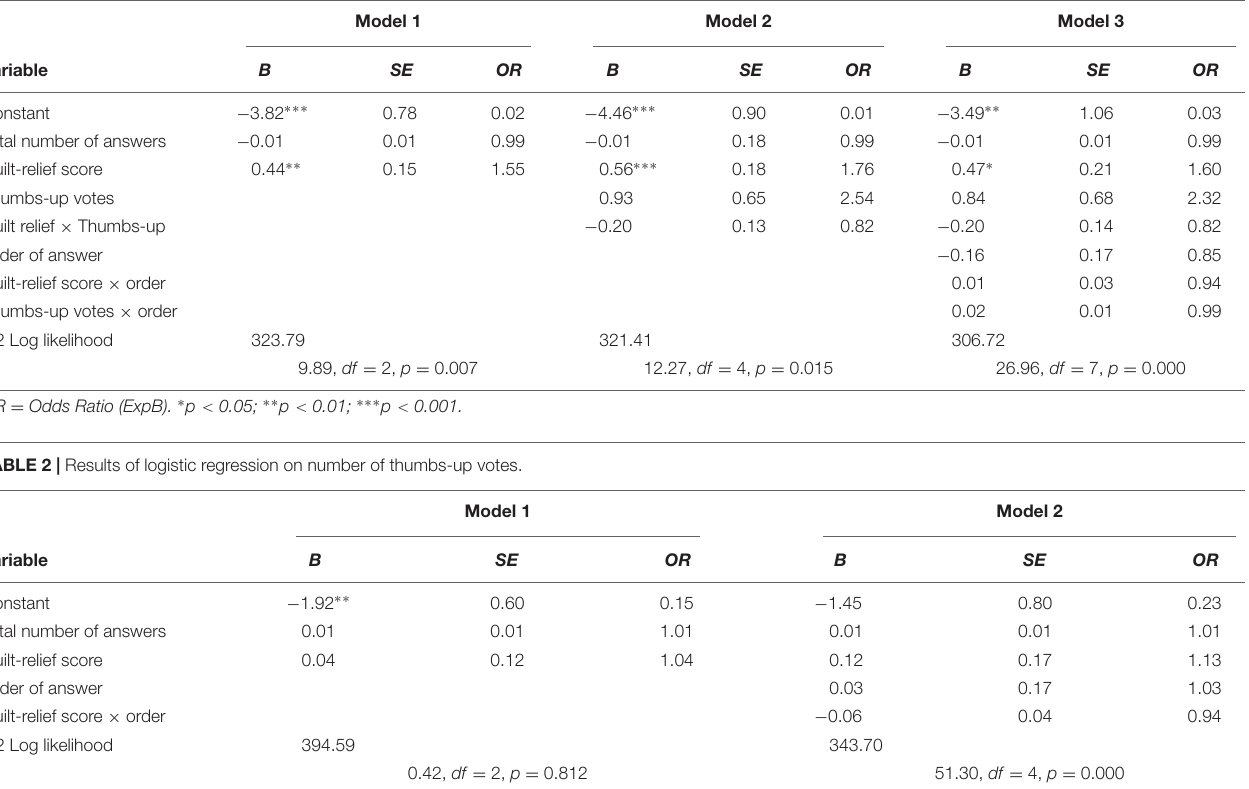
TABLE 1 | Results of logistic regression on the asker’s likelihood of choosing the answer as the best answer.